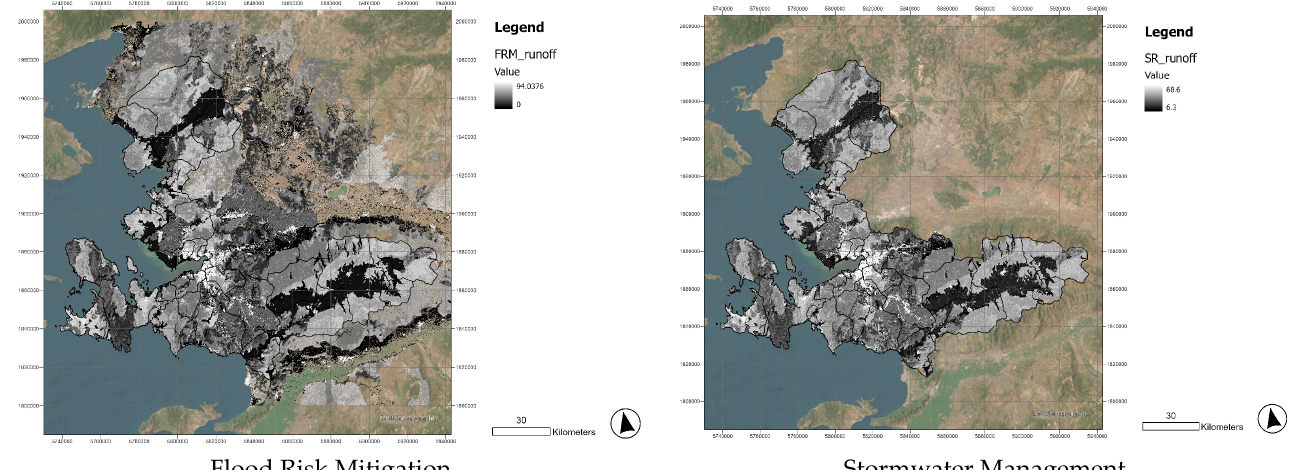
Figure 5. Runoff maps. flood risk mitigation ( left ) and stormwater management ( right ). Source: author’s elaboration elaborated by InVEST.